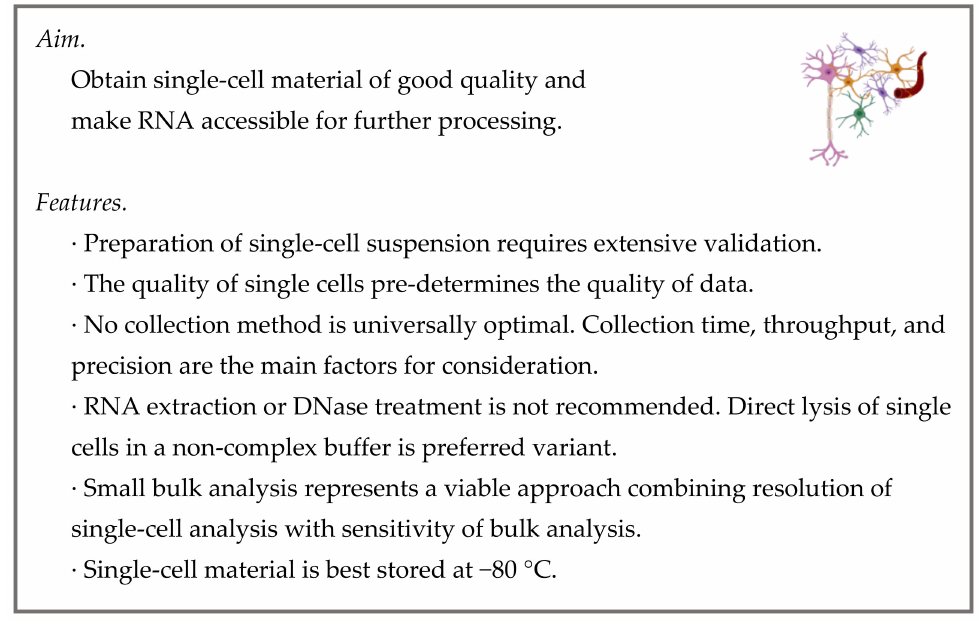
Figure 2. Sample